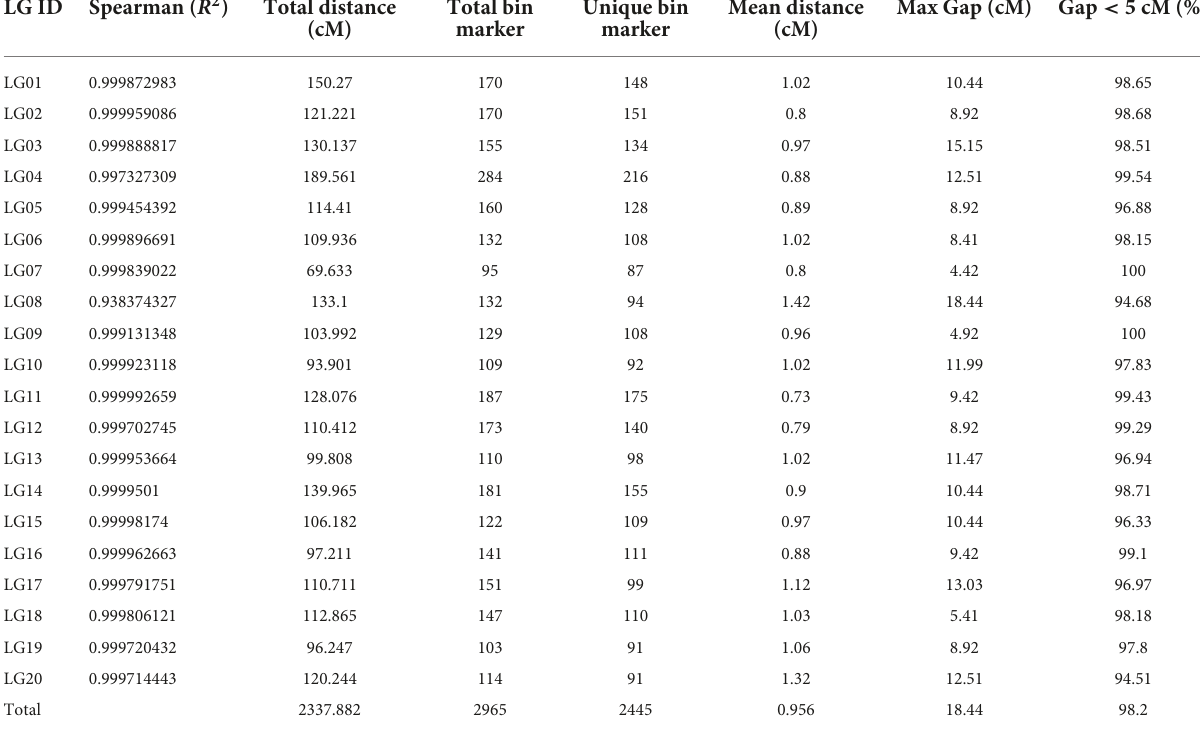
TABLE 1 Basic information statistics of the genetic